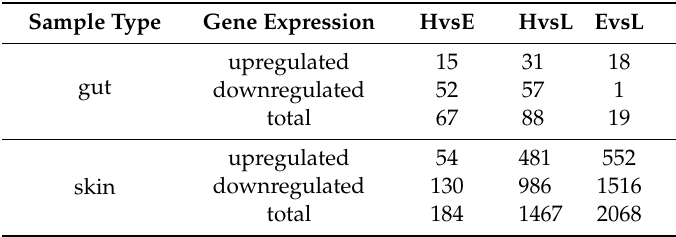
Table 1. Table representing the number of di ff erentially expressed genes (DEGs) in the gut and skin of fish exhibiting di ff erent health states (H = healthy, E = early stage of enteritis and L = late stage of